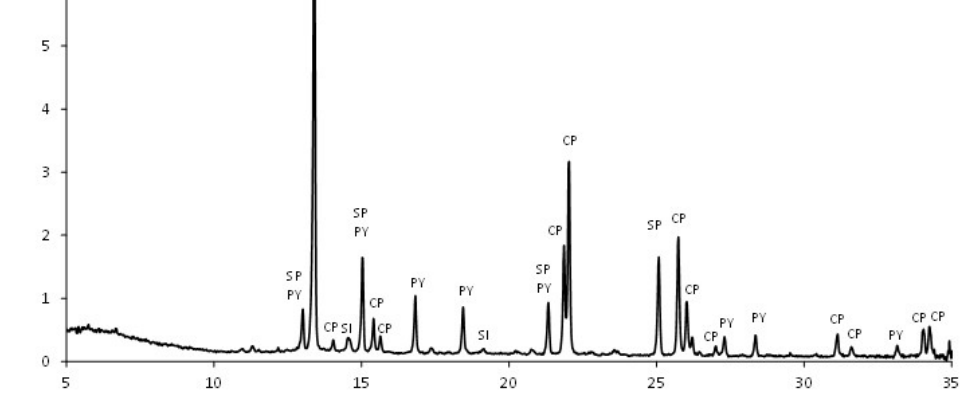
Figure 1. XRD pattern of CPY sample.